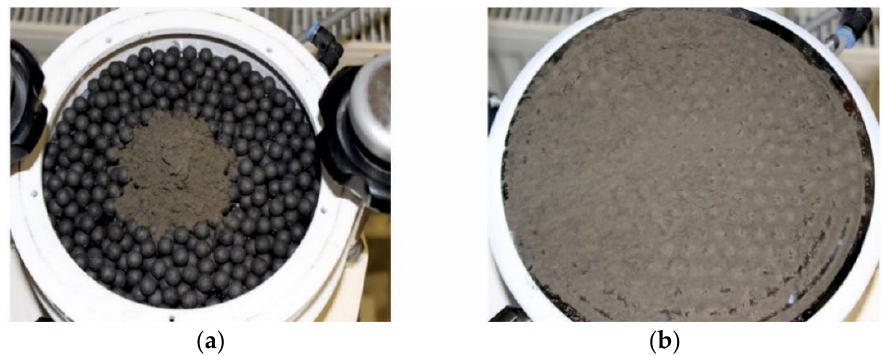
Figure 10. ( a ) Photograph of the chuck assembly with mounted substrate after placing rubber balls on its surface and pouring of NdFeB powder. In ( b ) the same substrate is shown after completed mold filling, dismounting of the vacuum chuck from the shaker setup and rubber ball removal by tilting the chuck assembly.